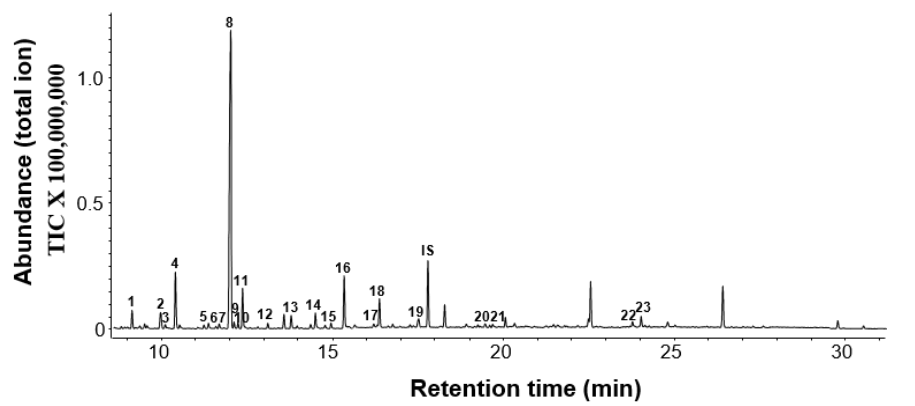
Figure 1. Gas chromatograph (GC) profile of floral volatile emission in C. florida ‘Kaiser’ at the full blooming stage. Separation of volatile compounds was performed on an Agilent HP 5 MS capillary column. Compounds identified from floral volatile blend are labeled with 1–23. ( 1 ) 2-Hydroxyethyl methacrylate, ( 2 ) Limonene, ( 3 ) Benzyl alcohol, ( 4 ) 2-Phenylacetaldehyde, ( 5 ) trans -Linalool oxide, ( 6 )